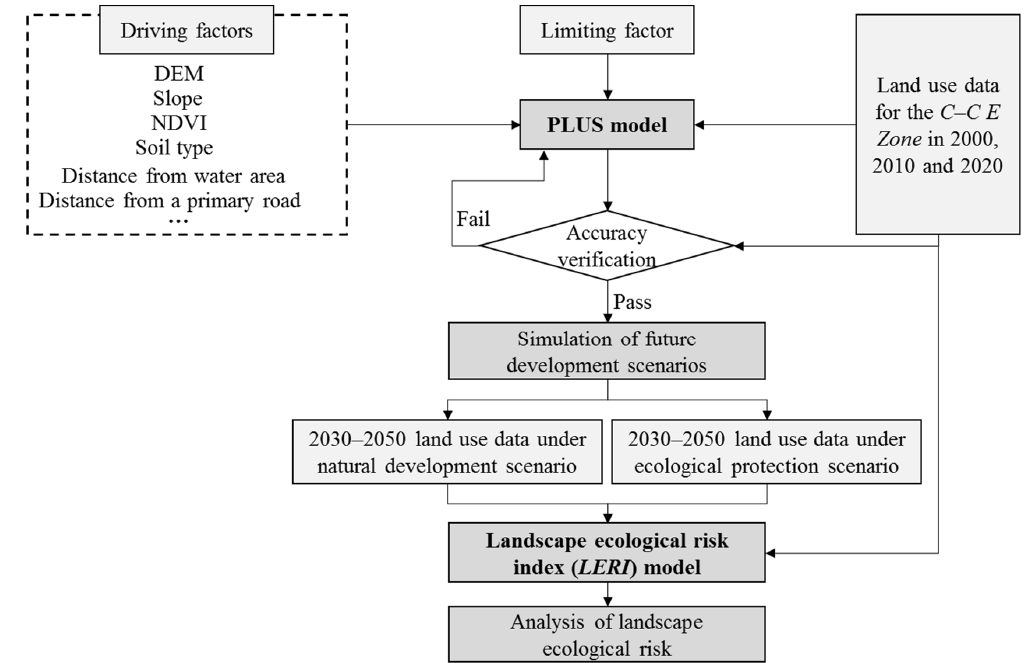
Figure 1. Research framework map.